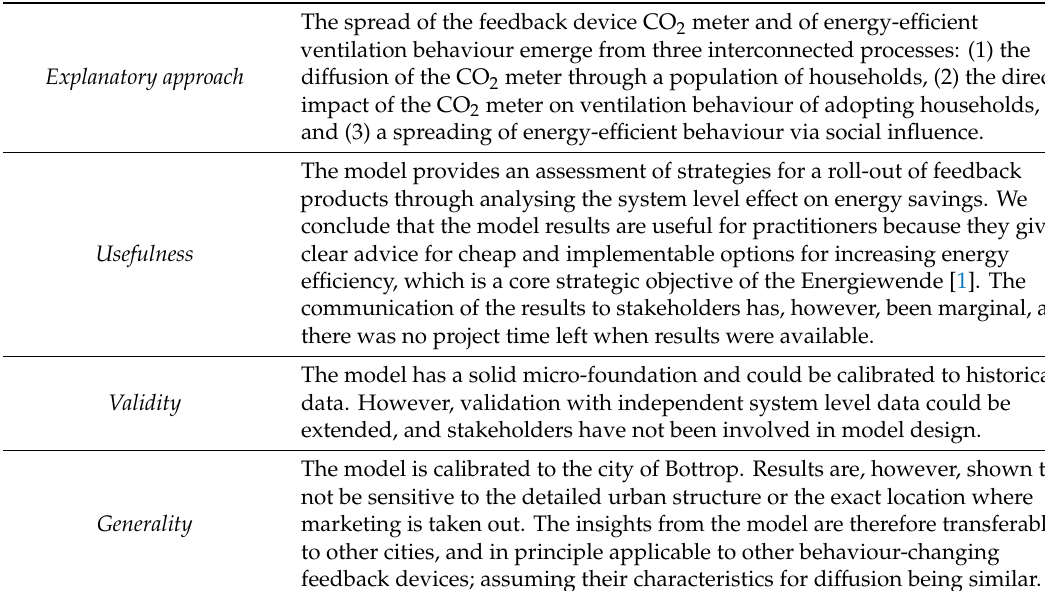
Table 3. Overall summary and assessment of case 3 (feedback products) with regard to explanatory approach, usefulness, validity and